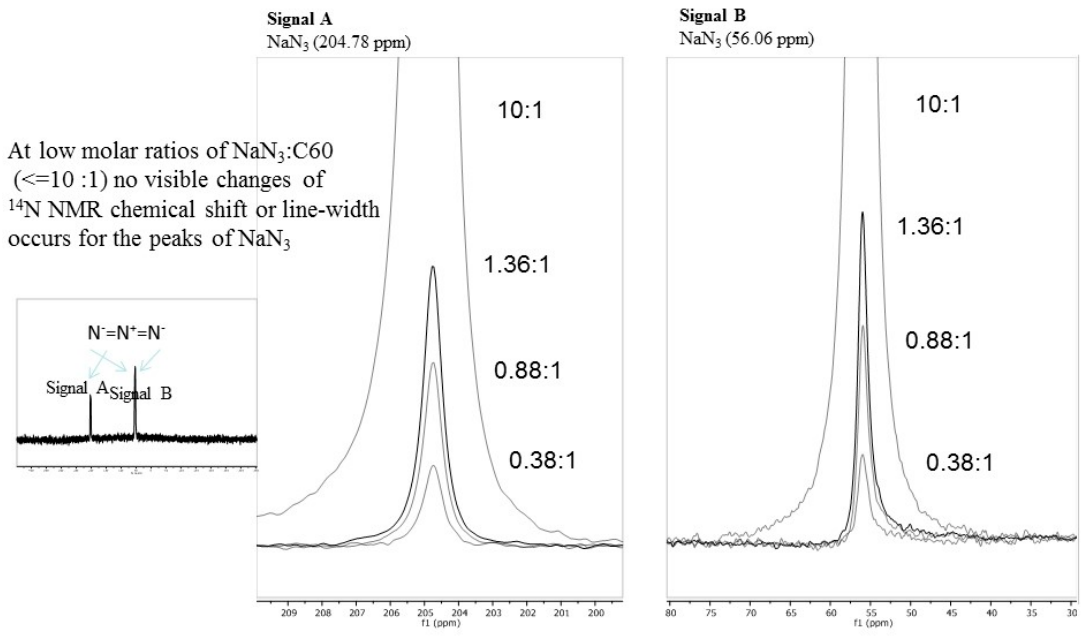
Figure 3. 14 N NMR superimposition of four different spectra at low molar ratios of NaN 3 :C60 ( ≤ 10:1).